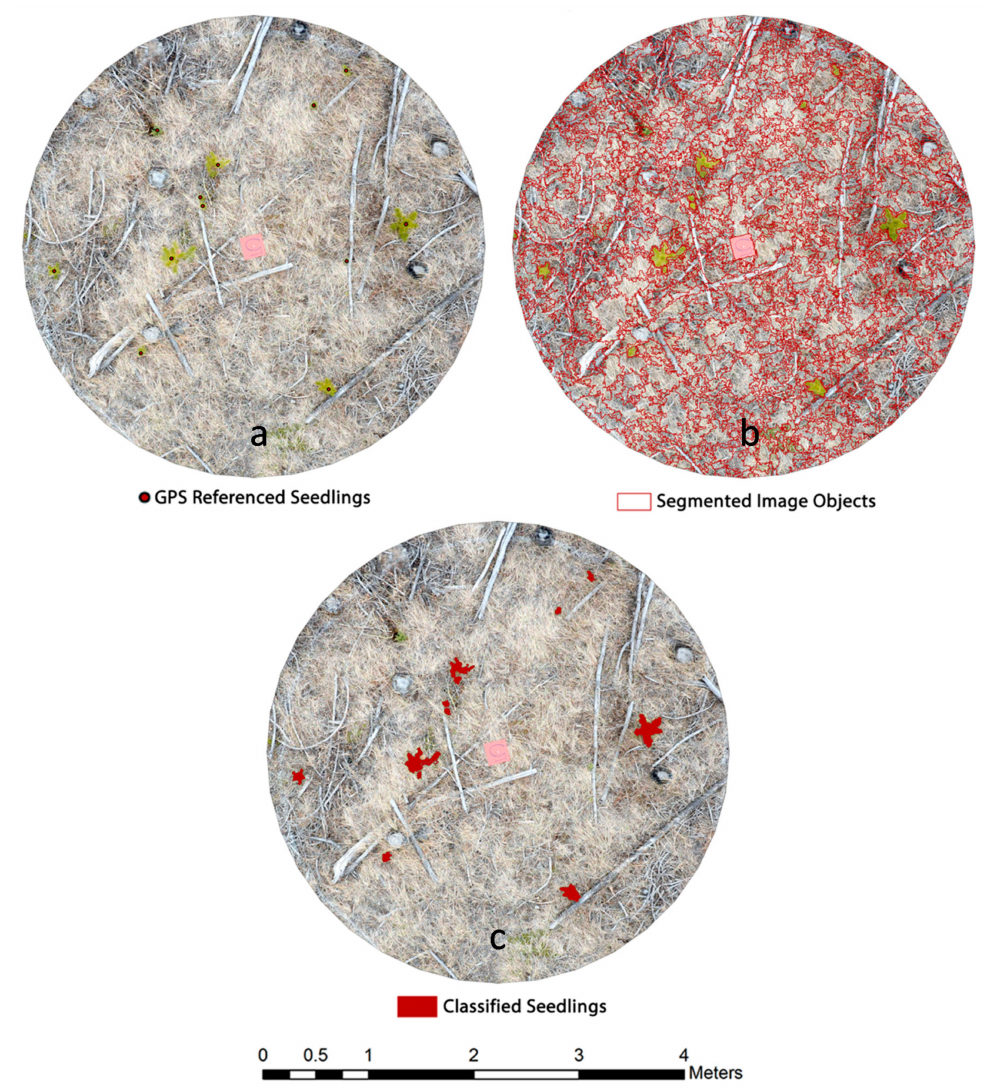
Figure 5. GNSS-surveyed reference seedlings ( a ) were surveyed in the field by trained personnel. UAV imagery was segmented into image objects ( b ) and subject to a decision-tree classification based on spectral indices from RGB imagery. The final output ( c ) delineates individual seedlings, whose accuracy was checked against the reference